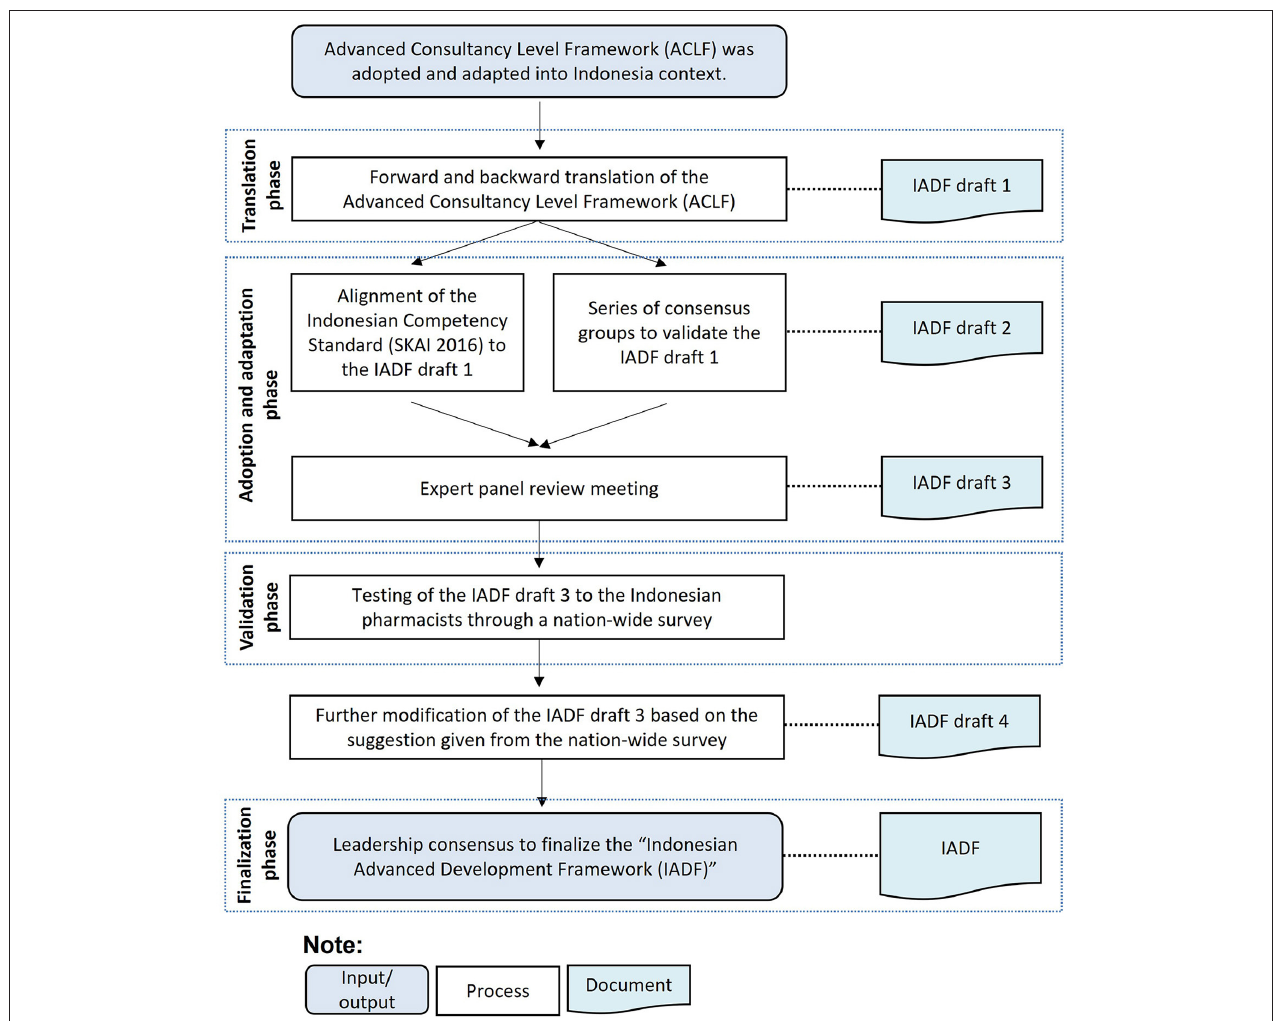
FIGURE 1 | The development process of the Indonesian Advanced Development